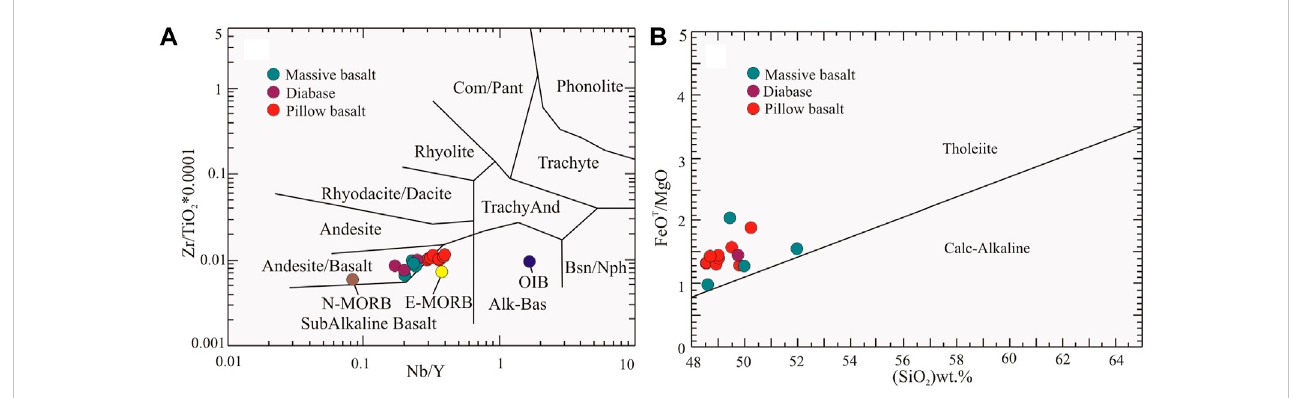
FIGURE 6 (A) Zr/TiO 2 -Nb/Y diagram (Winchester and Floyd, 1977) and (B) SiO 2 -FeO T /MgO diagram (Miyashiro, 1974) of the basic igneous rocks in the Bairin Right Bannerarea,InnerMongolia.Abbreviations:N-MORB, Normalmid-oceanridgebasalt;E-MORB, Enrichedmid-oceanridgebasalt;OIB,oceanicislandbasalt; values are from Sun and McDonough,